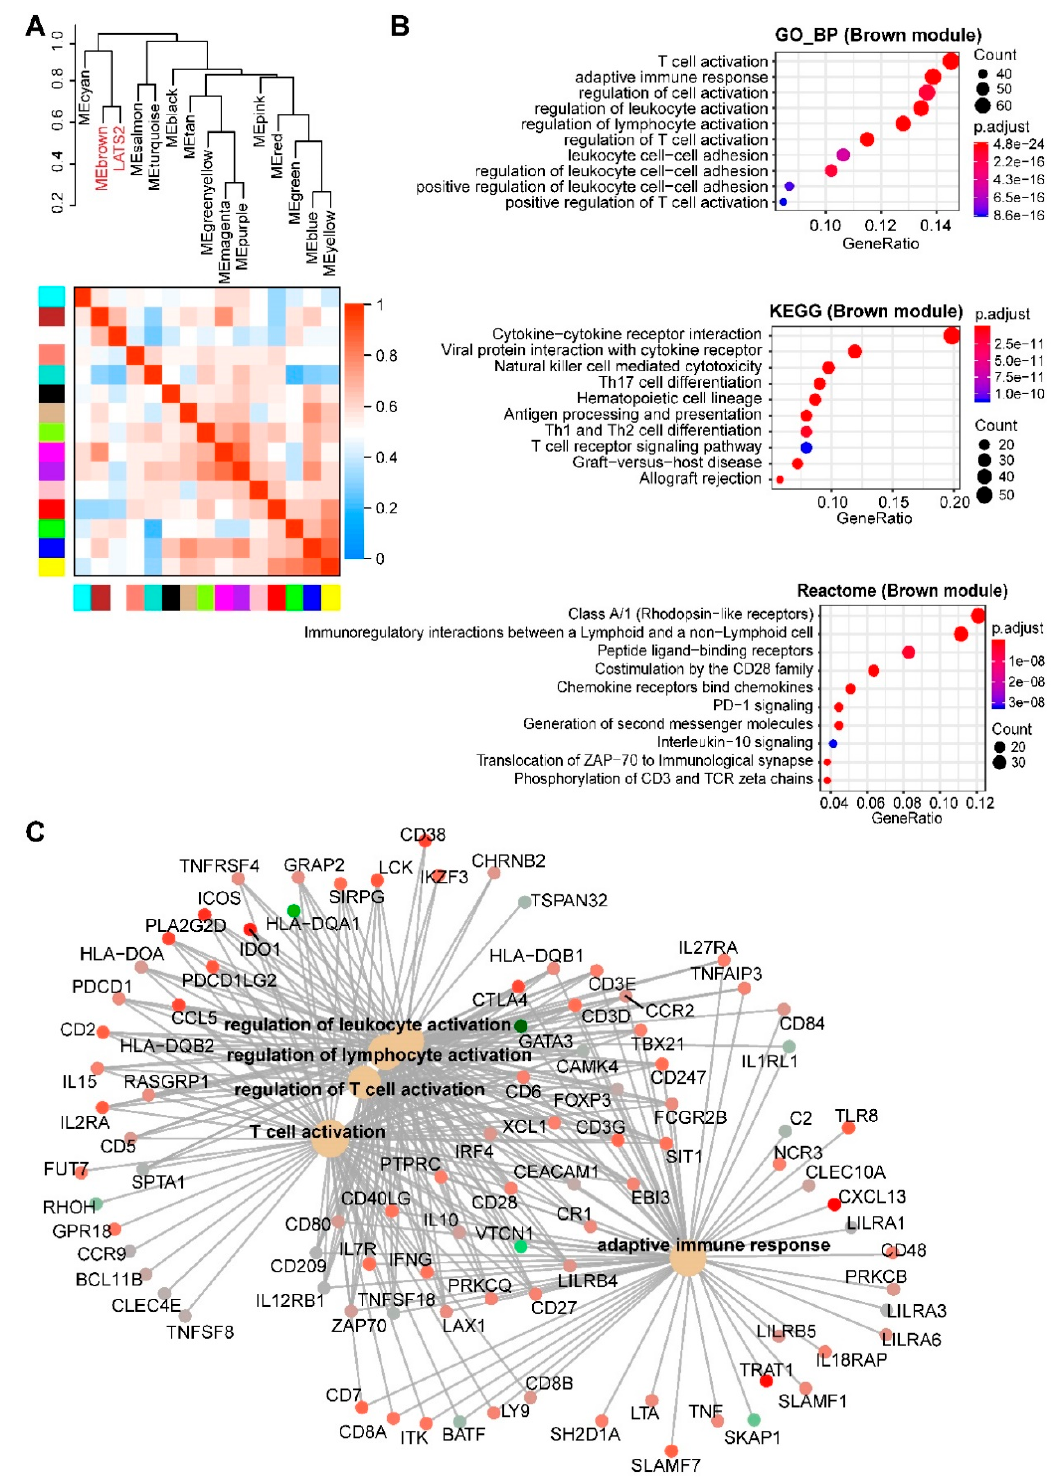
Figure 5. Enrichment analyses of genes significantly correlated with MPM tumors with LATS2 alterations. ( A ), Hierarchical clustering dendrogram of module eigengenes (labeled by their colors) and the sample trait (genetic alterations). Heatmap plot of the adjacencies in the eigengene network. In the heatmap, each row and column corresponds to one module eigengene (labeled by colors) or the trait. In the heatmap, green color indicates a negative correlation, while red represents a positive correlation. ( B , C ), Top 10 significantly enriched GO (biological process, BP), Kyoto Encyclopedia of Genes and Genomes (KEGG) and Reactome ( C ) pathways based on genes in the brown module. Cnetplot in C listed genes in the enriched Reactome pathways ( B ).